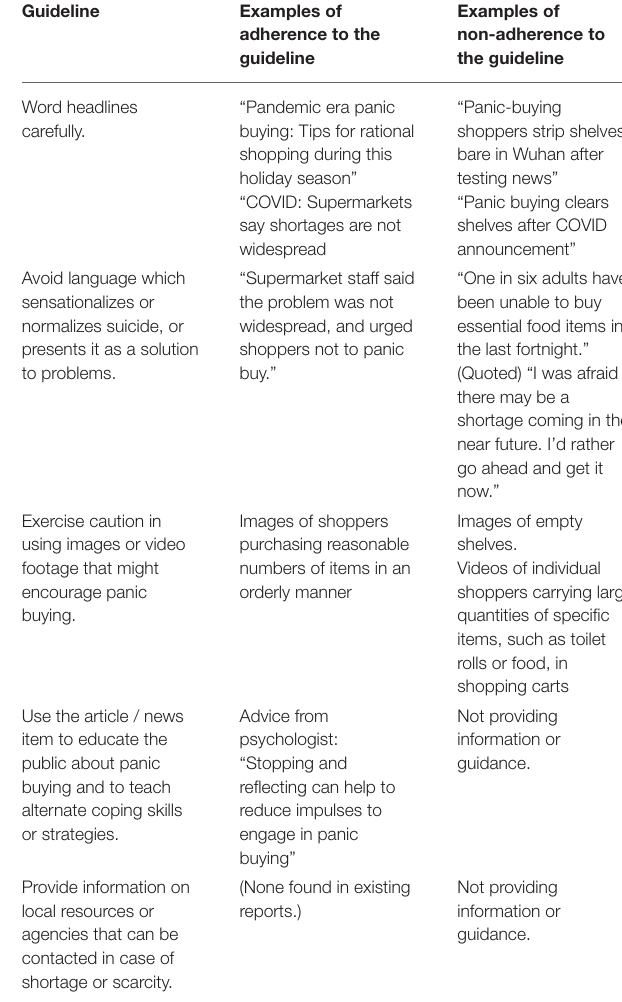
TABLE 2 | Sample analysis of news articles using the modified WHO